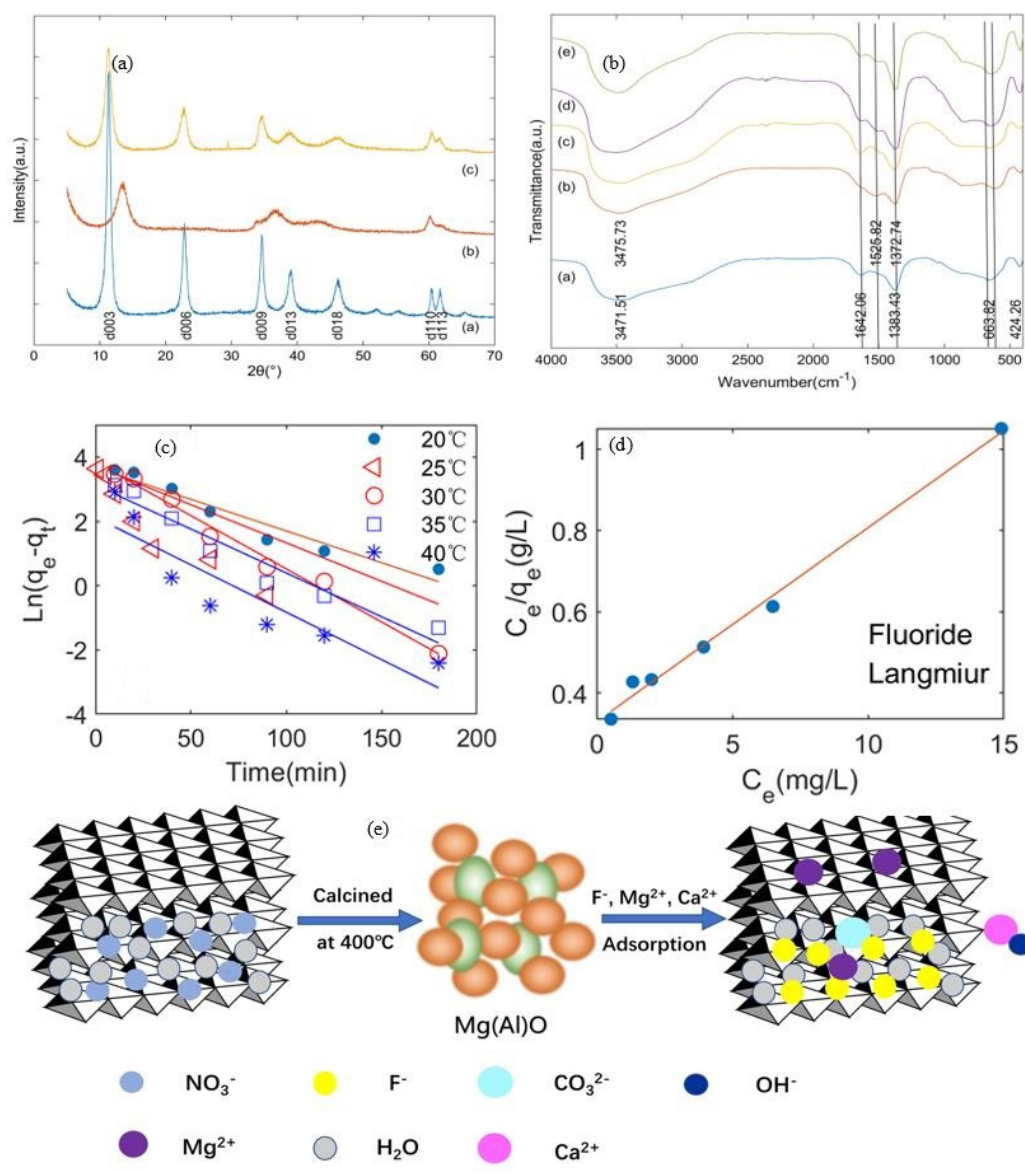
Figure 3. Adsorption of fluoride by CLDHMA. ( a ) XRD result of CLDHMA; ( b ) FI−IR result of CLDHMA; ( c ) adsorption kinetics of fluorine by CLDHMA; ( d ) adsorption isotherm of fluorine by CLDHMA; and ( e ) adsorption mechanism of fluoride by CLDHMA [61].